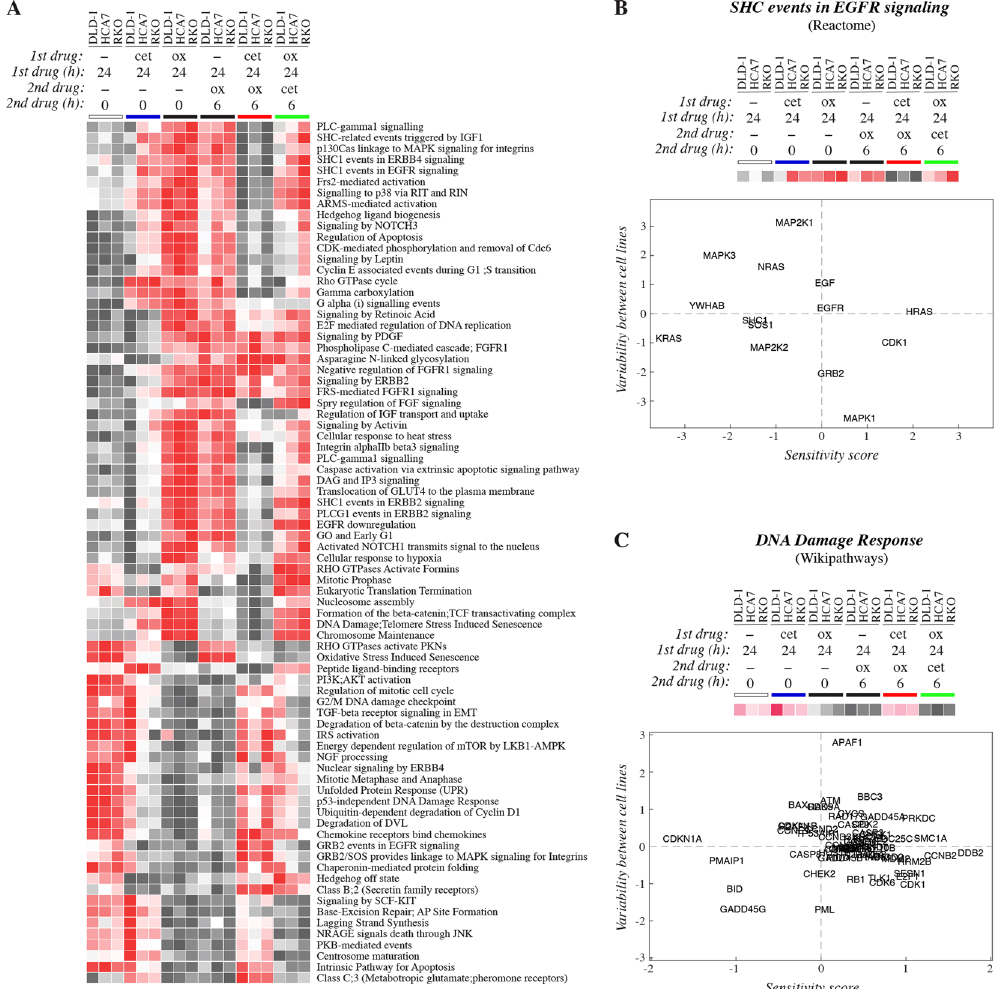
Figure 3. RNAseq analysis of transcriptomic profiles induced by sequential treatments. DLD-1, HCA7, and RKO cells were subjected to different regimens containing 10 μ g/ml cetuximab and/or 50 μ M oxaliplatin: (1) control medium for 24 hours (white bar), (2) cetuximab for 24 hours (blue bar), (3) oxaliplatin for 24 hours (left black bar), (4) control medium for 24 hours followed by oxaliplatin for 6 hours (right black bar), (5) cetuximab for 24 hours followed by oxaliplatin for 6 hours (red bar), or (6) oxaliplatin for 24 hours followed by cetuximab for 6 hours (green bar). Gene expression was analyzed using RNAseq. ( A ) Data were sectioned into pathway matrices according to the annotations of the Reactome database and converted into a heatmap. ( B , C ) Sensitivity scores reflecting changes in the expression of single genes in response to the different treatment protocols were plotted against the variation in the expression between the three different cell lines. Data are shown for sets of genes constituting two pathways, one reflecting differential responses to EGFR manipulation (“SHC events in EGFR signaling”) ( B ), and the other differential responses to the DNA damage induction by oxaliplatin (“DNA Damage Response”) ( C ). The two pathways were based on annotations by the Reactome ( B ) and Wikipathways ( C ) databases also shown as heatmaps in panel A and Suppl. Fig. 5,